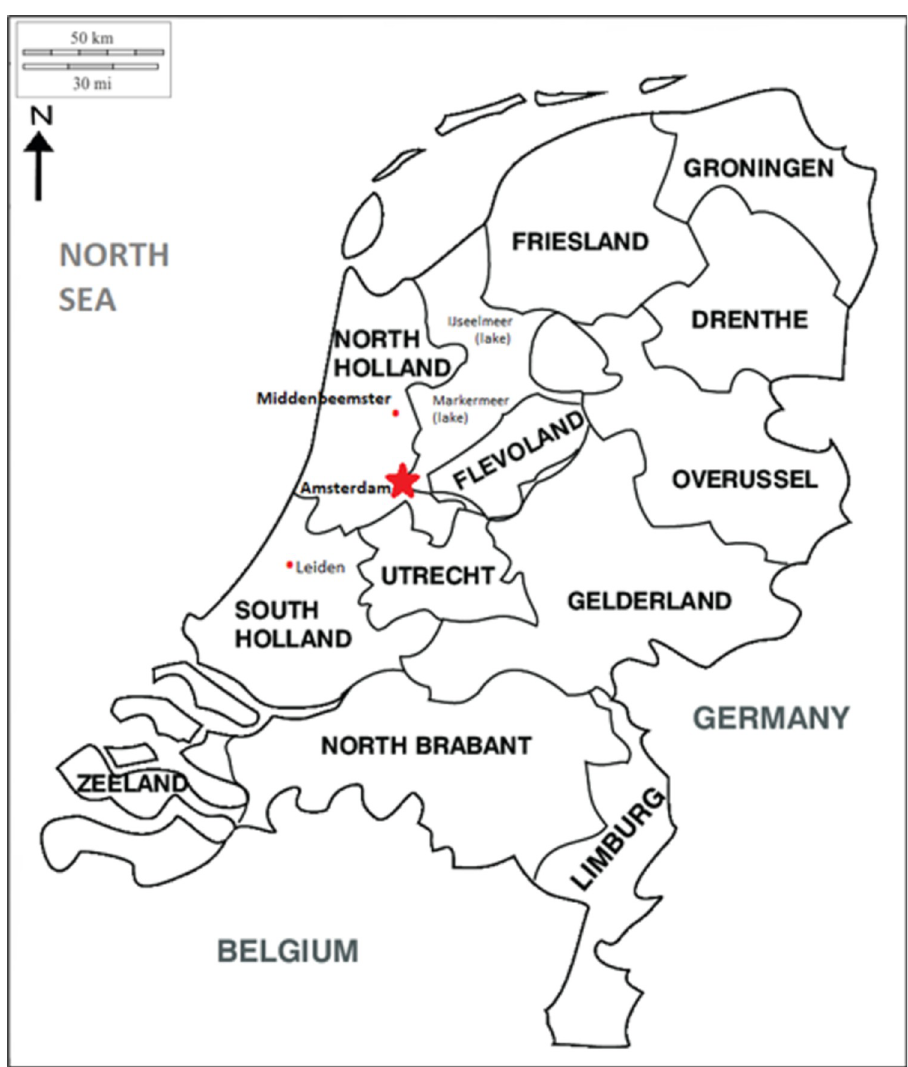
Fig 1. The Netherlands provinces showing location of the Middenbeemster